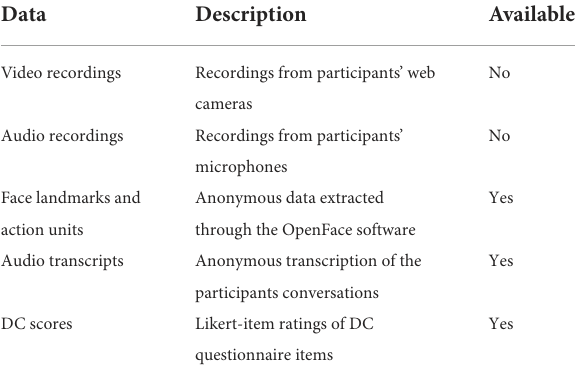
TABLE 1 The Digital Commensality Data-set content description and availability.